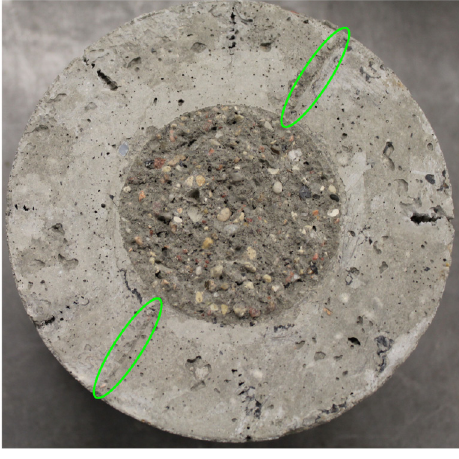
Fig. 7. Microstructure of the fractured concrete